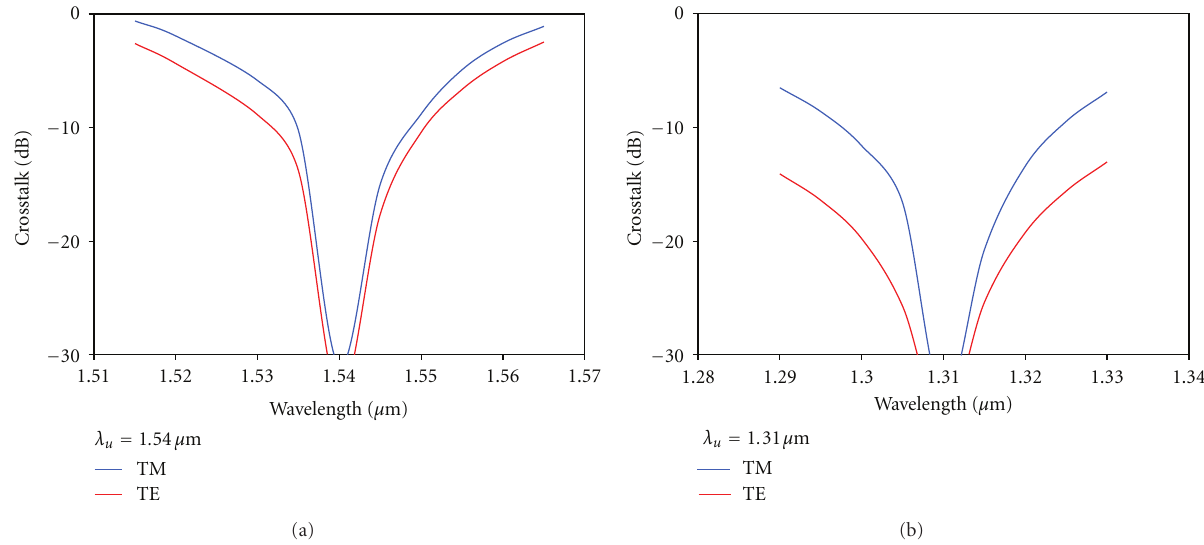
Figure 7: The crosstalk for TE and TM polarizations at (a) λ d = 1 . 31 μ m (at the cross-port) and (b) λ d = 1 . 54 μ m (at the bar port).